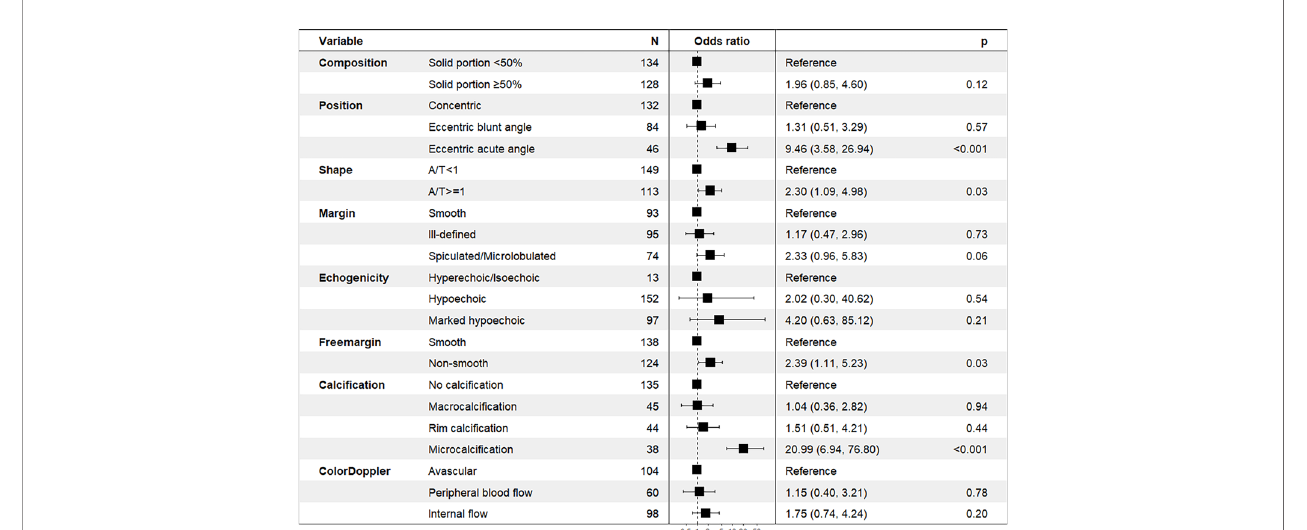
FIGURE 3 | A forest plot of the logistic regression analysis